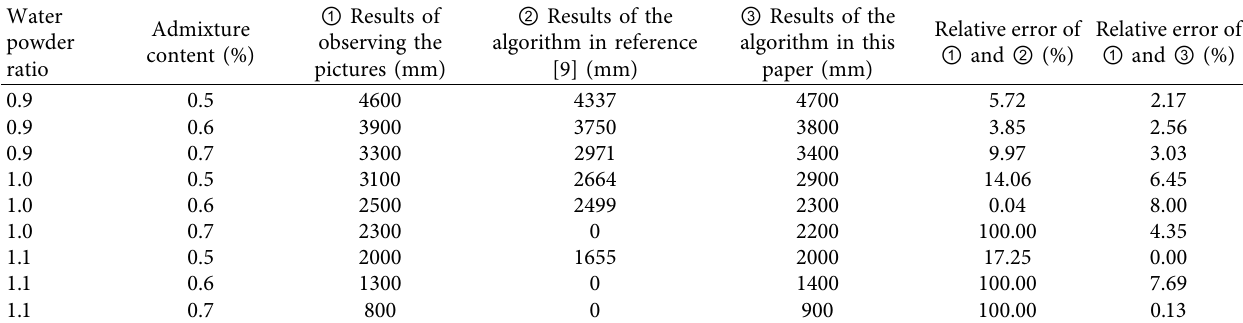
Table 2: Comparison of T200 measurement results of cement paste flowability test ① Results